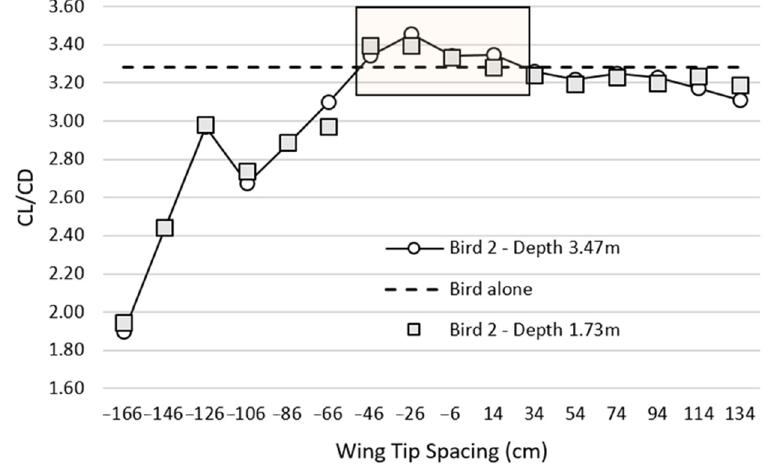
Figure 5. Evolution of the C L /C D ratio for the single bird and for the second bird of each case as a function of WTS and depth.